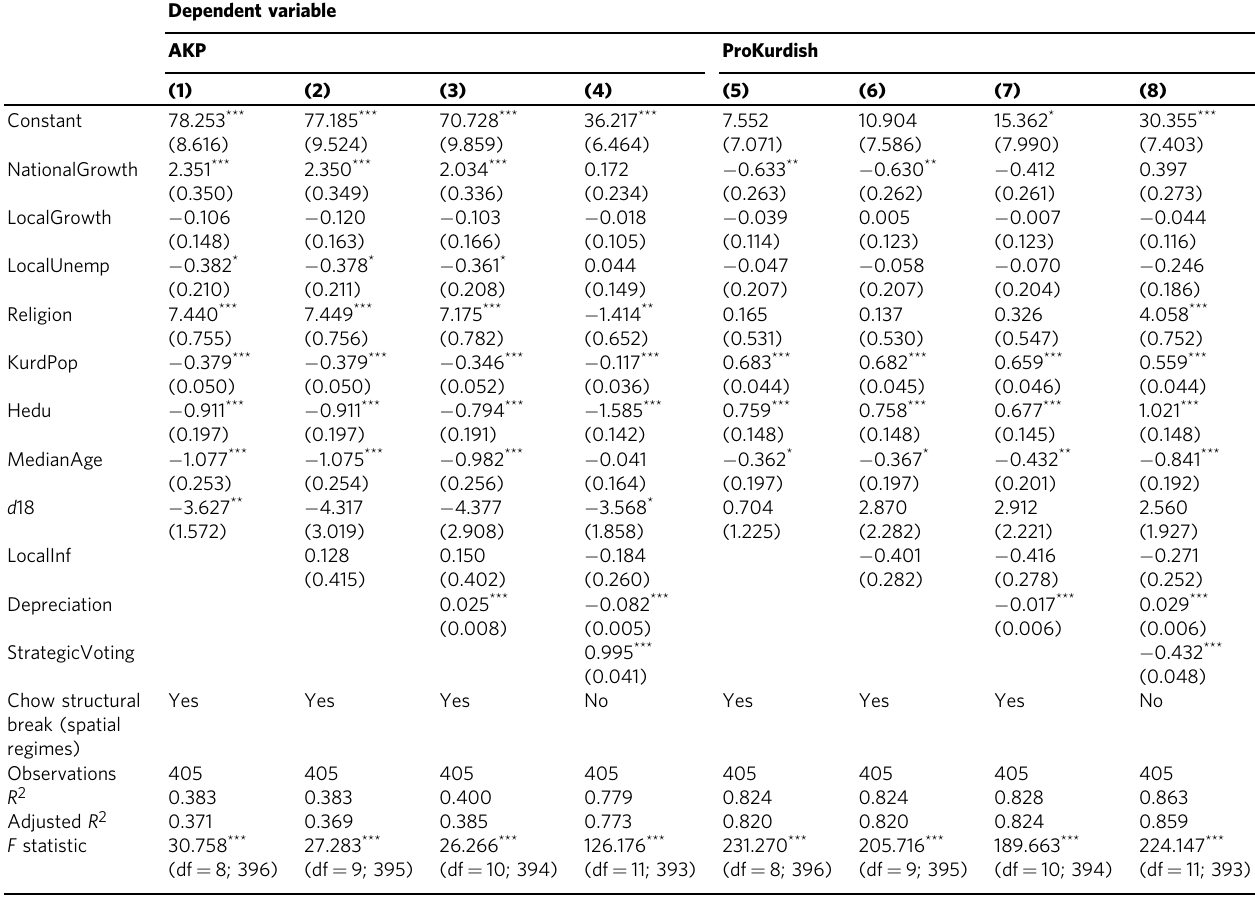
Table 2 Regression results for the AKP and Pro-Kurdish